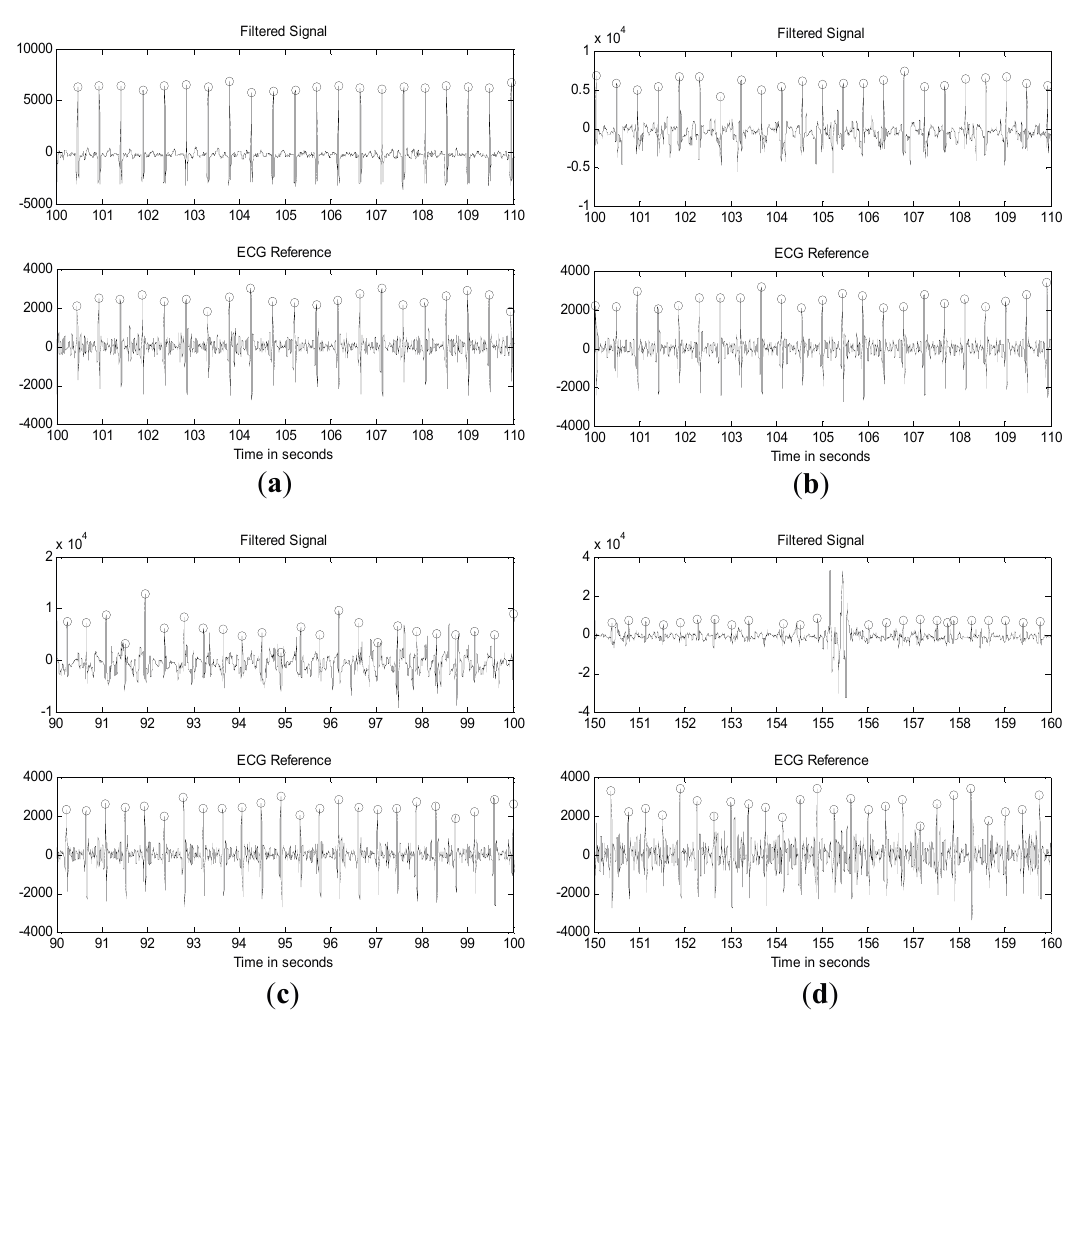
Figure 6. Signals acquired at different walking speeds: ( a ) 4 km/h; ( b ) 5 km/h; ( c ) 6 km/h; ( d ) 7 km/h (top: proposed system, bottom: reference